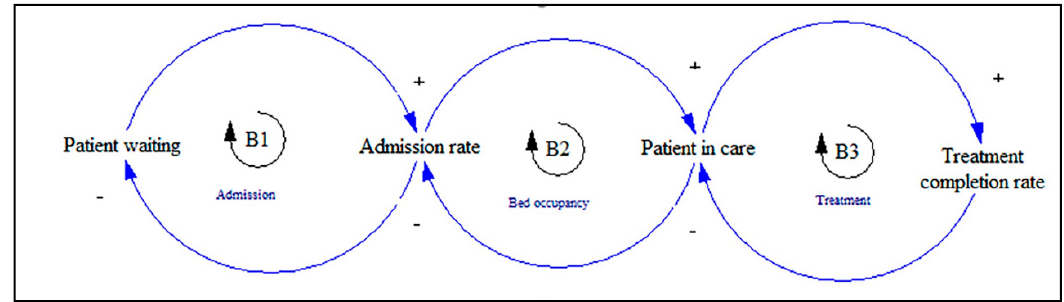
Figure 5. The core part of the causal loop diagram for patient flow.